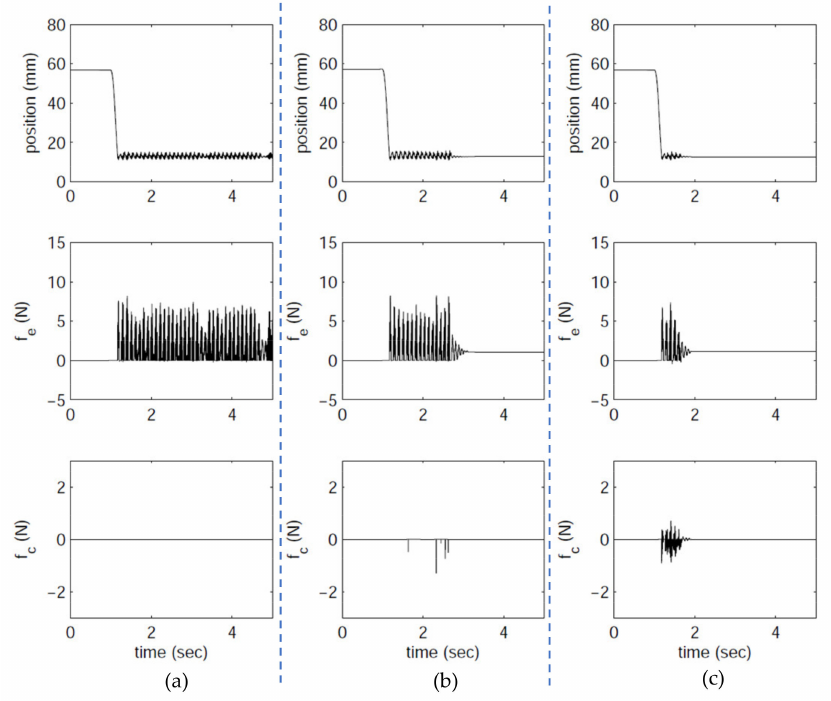
Figure 12. Experimental results at K = 4000 N/m, B = 1 Ns/m, α = 1 Ns/m: ( a ) controller free, ( b ) the basic passivity controller, and ( c ) the